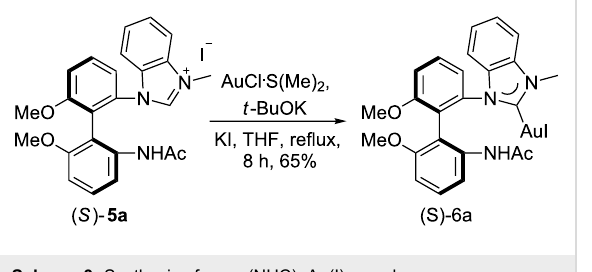
Scheme 3: Synthesis of mono(NHC)–Au(I) complex.